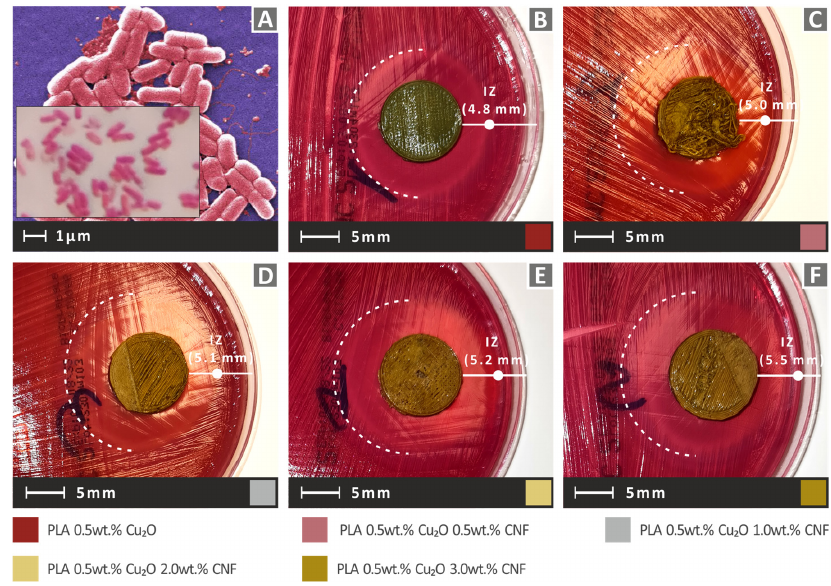
Figure 16. Antibacterial screening process for nanocomposites performance against E. coli bacterium: ( A ) typical E. coli morphology, ( B ) 0.5 wt.% Cu 2 O, ( C ) 0.5 wt.% Cu 2 O, 0.5 wt.% CNF, ( D ) 0.5 wt.% Cu 2 O, 1.0 wt.% CNF, ( E ) 0.5 wt.% Cu 2 O, 2.0 wt.% CNF, and ( F ) 0.5 wt.% Cu 2 O, 3.0 wt.%